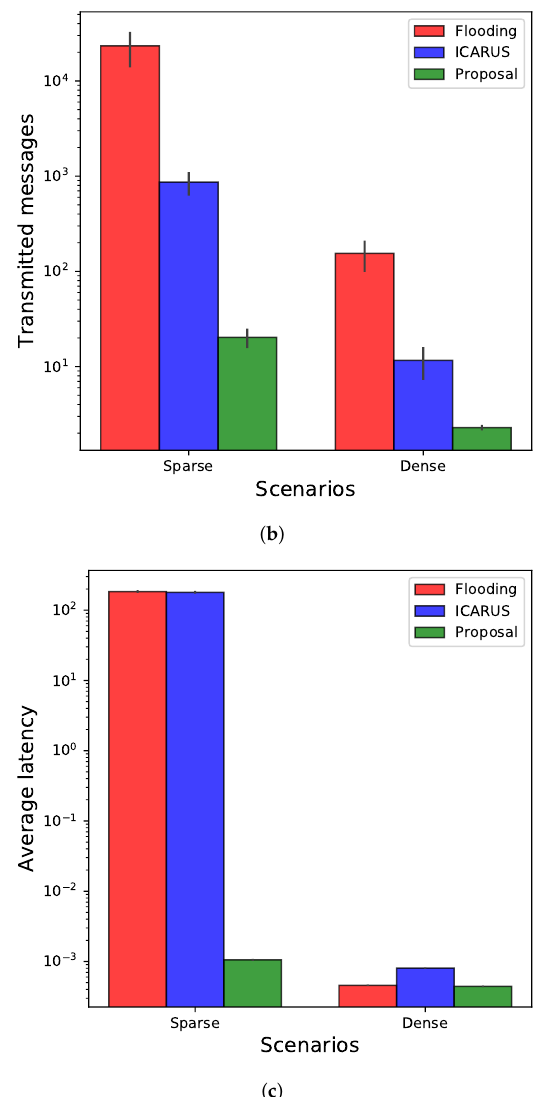
Figure 10. Network performance results for both sparse and dense scenarios. ( a ) Delivery ratio; ( b ) Transmitted messages; ( c )